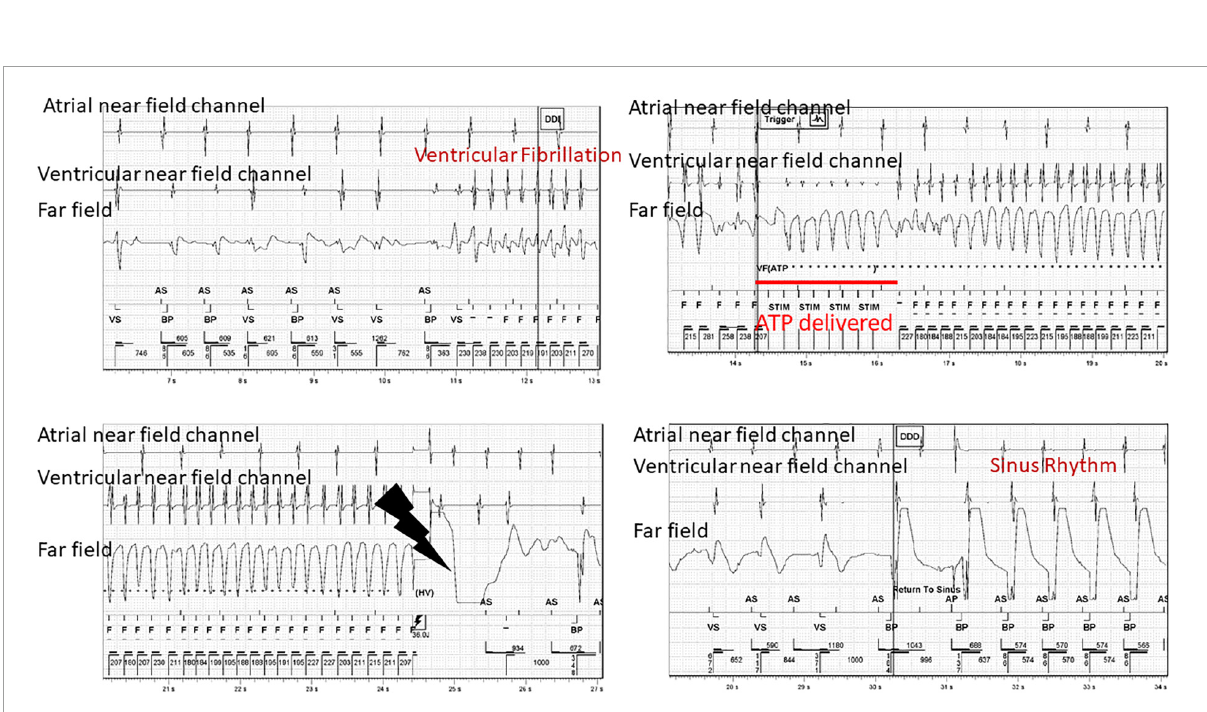
FIGURE2 Device tracings of a 70 year old male with ischemic heart disease and prior myocardial infarction who experienced ventricular fibrillation that resulted in delivery of anti-tachycardia pacing and then eventually defibrillation. This event occurred during sexual activity. AS, atrial sensing; VS, ventricular sensing, F, fibrillation zone; STIM, anti-tachycardia